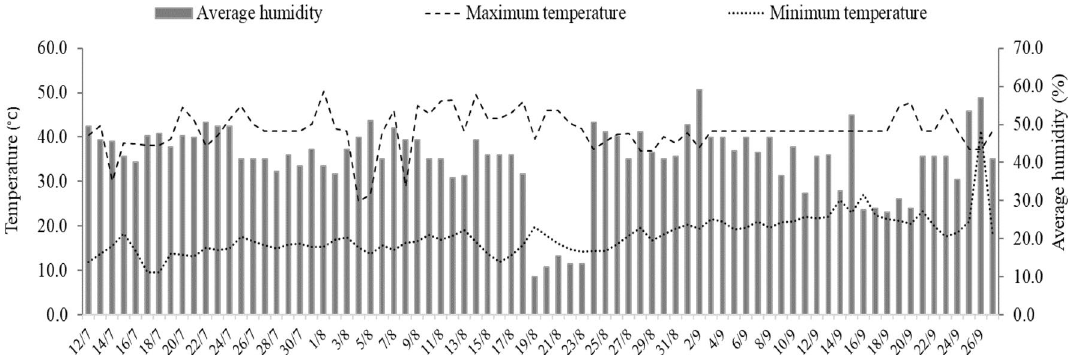
Figure 1. Minimum and maximum temperature (°C), and relative air humidity (%) recorded using a thermo- hygrometer during the experimental period inside the greenhouse. Software used to create this Figure was Microsoft Excel (v1804, https:// www. micro soft.